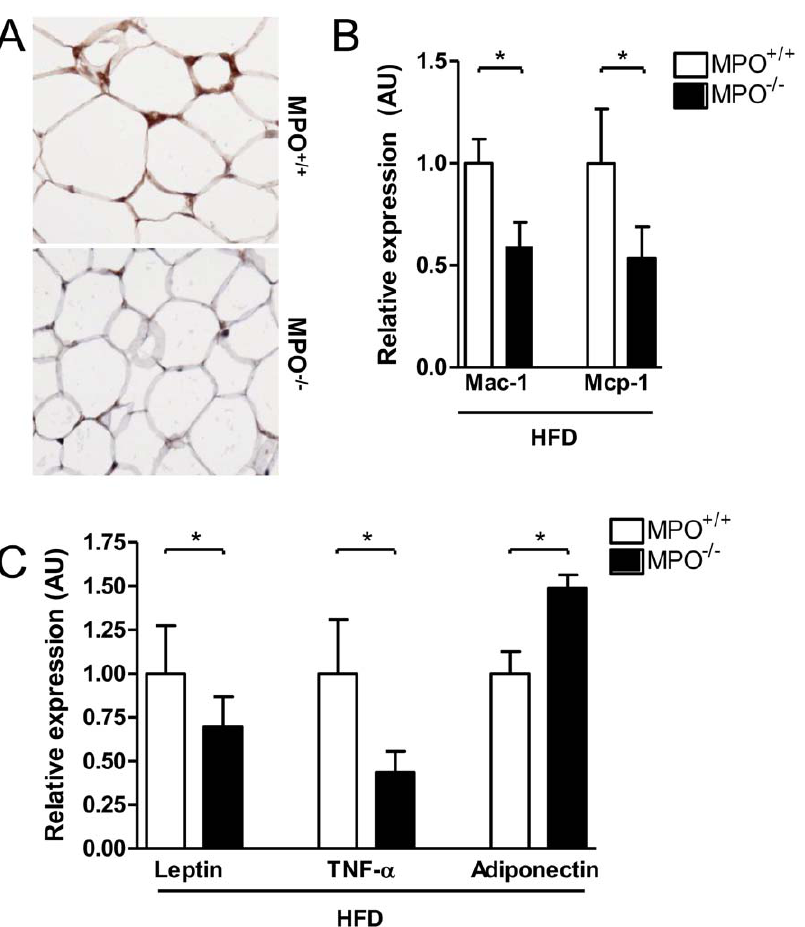
Figure 6. Reduced diet-induced adipose tissue inflammation in LDLR 2 / 2 / MPO 2 / 2 tp mice. A) Lack of high-fat diet-associated macrophage ‘crown-like structures’ in visceral adipose tissue of LDLR 2 / 2 / MPO 2 / 2 tp mice as revealed by F4/80 immunostaining (200 6 magnification). B) Adipose tissue mRNA expression of the macrophage marker Mac-1 and the macrophage chemokine Mcp-1 is significantly lower in LDLR 2 / 2 / MPO 2 / 2 tp mice fed a high-fat diet for 8 weeks (p , 0.05). C) Reduced adipose tissue expression of the adipokines leptin and TNF- a in LDLR 2 / 2 / MPO 2 / 2 tp mice after 8 weeks of high-fat feeding, whereas expression of adiponectin is increased.